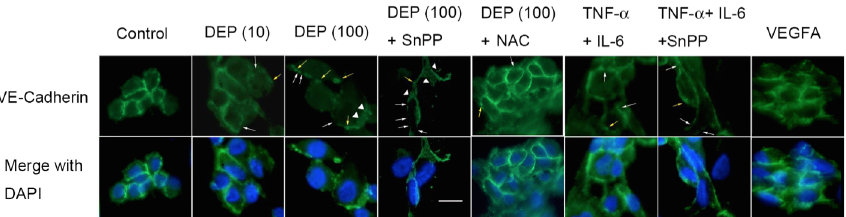
Fig 6. DEPs and the induced cytokines caused capillary VE-cadherin redistribution. Endothelial tube cells were treated for 24 h with DEPs ± SnPP or TNF- α +IL-6 ± SnPP. An endothelial tube cell culture treated for 24 h with 100 ng/mL VEGFA was the positive control. VE-cadherin localization was then determined by epifluorescence imaging. White arrows indicate areas where VE-cadherin showed discontinuity around the cell membrane. Arrowheads indicate instances where VE-cadherin moved from the cell membrane to the interior and intracellular submembrane regions. Yellow arrows indicate cell-cell separations and globules of VE-cadherin that accumulated intracellularly near the cell